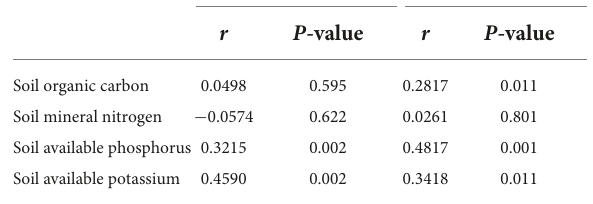
TABLE 3 Mantel test correlations between soil microbial community structure and soil properties. Soil